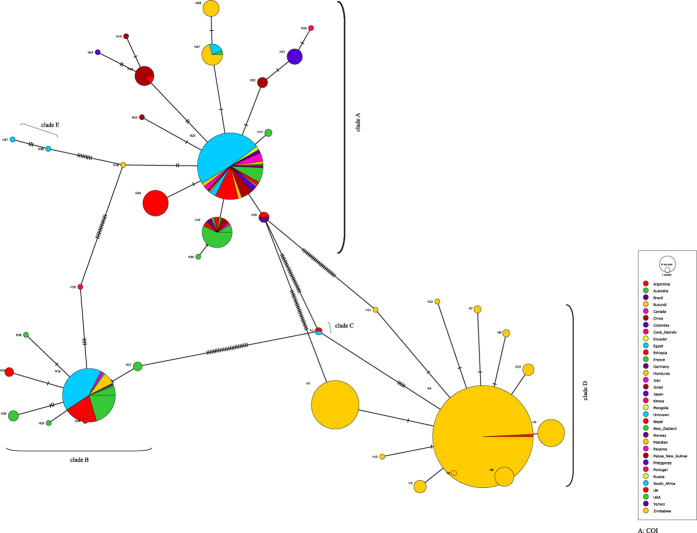
COI haplotype networks of head lice.Each circle indicates a unique haplotype and variation in circle size reflects the number of sequences assigned to a haplotypes. Pie colors and sizes in circles represent the countries and the number of their sequence records for a haplotype.